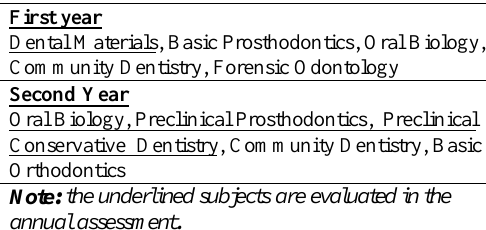
Table II : Organisation of dental sciences in the pre-clinical phase of undergraduate curriculum